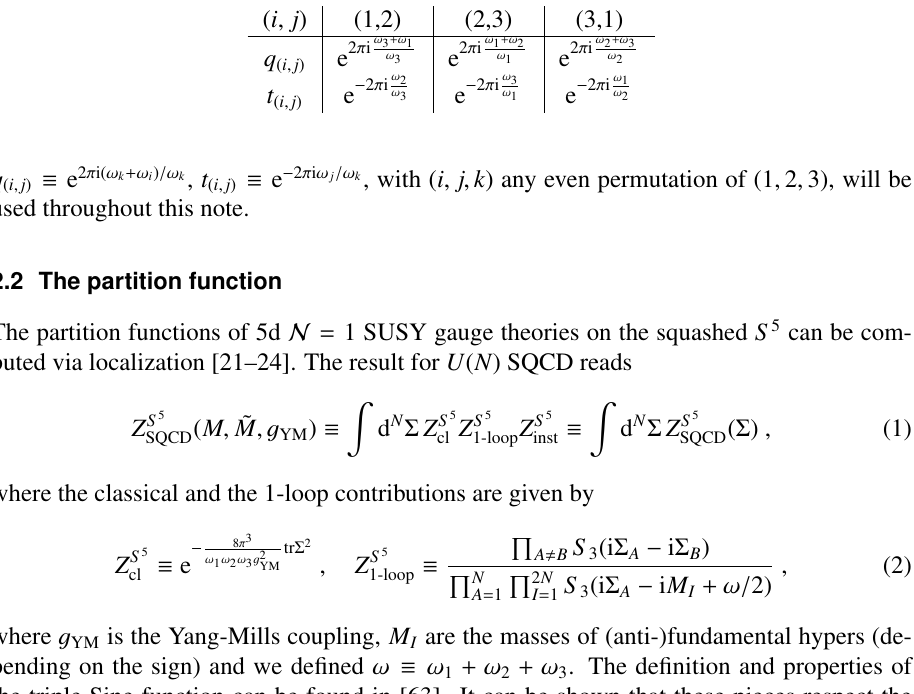
Table 1. The 5d squashing parameters can be reorganized into a set of exponentiated parameters. Each column can be associated to a vertex of the triangle in Figure 1, as indicated by the subscripts ( i , j